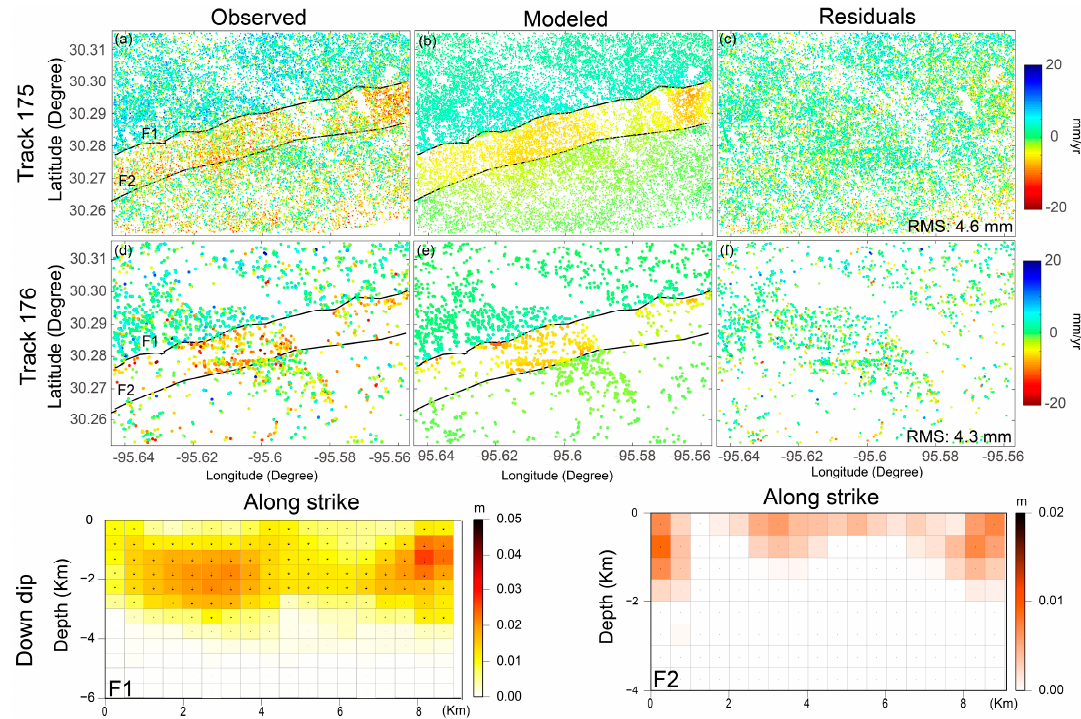
Figure 8. Observed ( a and d ), modeled ( b and e ), and residual ( c and f ) average vertical deformation maps of the two independent tracks (i.e., 176 and 175) of InSAR data. The black line shows the location of the fault. ( g and h ) show slip rate distribution maps of fault F1 and F2, respectively.